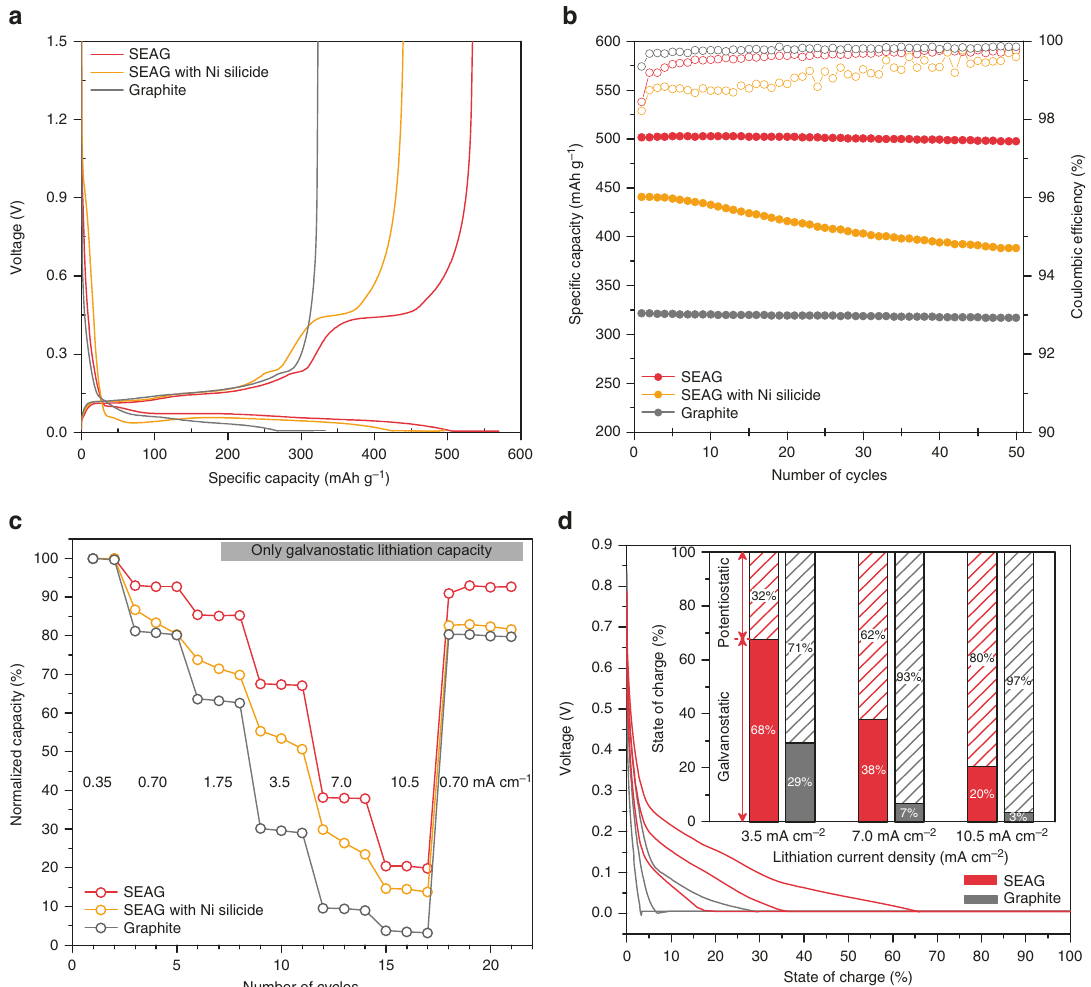
Fig. 4 Electrochemical characterization of various anodes in half-cell con fi gurations. a Voltage pro fi les of SEAG, SEAG with Ni silicide, and graphite in the 1st cycle. b Plots of reversible capacity and cycling CE vs. cycle number for SEAG, SEAG with Ni silicide, and graphite over 50 cycles. The a 1st cycle and b cycling test were carried out at current densities of 0.35 and 1.75 mA cm − 2 , respectively (1C = 3.5 mA cm − 2 ). c Galvanostatic charge capacities of SEAG under various lithiation current densities from 0.35 to 10.5 mA cm − 2 , compared to SEAG with Ni silicide and graphite. d Voltage pro fi les during charging process of SEAG and graphite, measured at increasing current densities from 3.5 to 10.5 mA cm − 2 ; the inset shows a plot of SOC divided